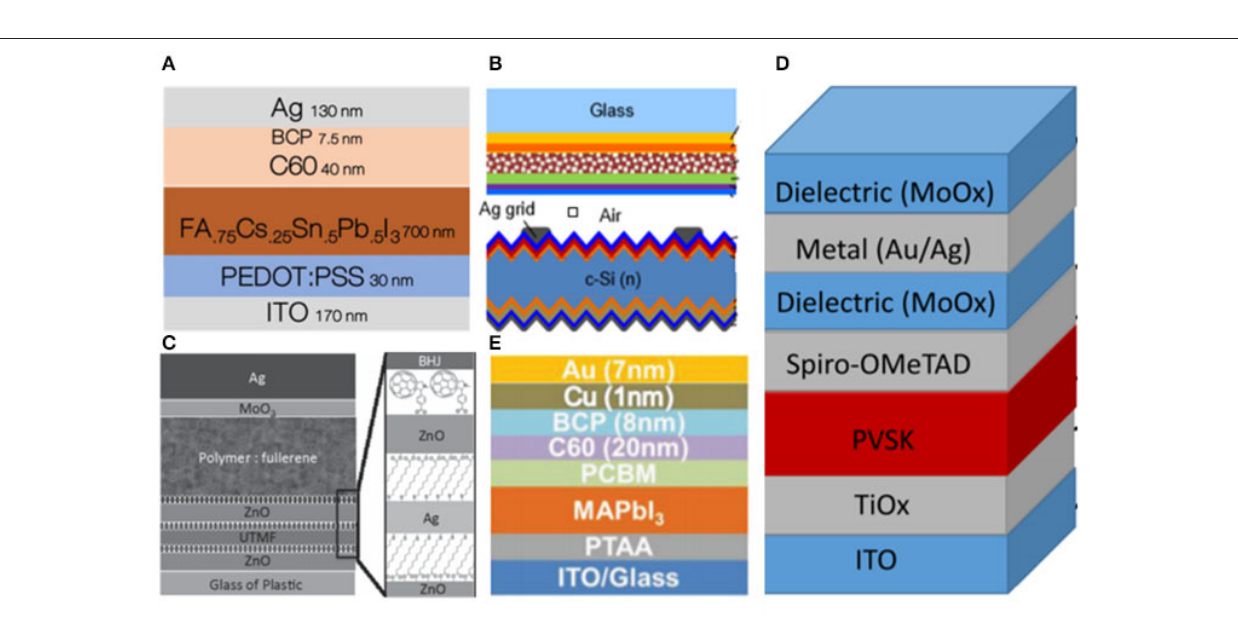
FIGURE 5 | (A) Device schematic of the single junction solar cell (reproduced from ref. 33, copyright 2018, Royal Society of Chemistry). (B) Schematic of the mechanically stacked 4T tandem (reproduced from ref. 34, copyright 2014, Royal Society of Chemistry). (C) Schematic drawing of the PSC devices and the molecular structure of MUA and C 60 -SAM employed for interfacial modifications (reproduced from ref. 35, copyright 2014, Wiley VCH). (D) Device structure and performance of top illuminated PVSK solar cell (reproduced from ref. 36, copyright 2015, ACS). (E) Schematic drawing of tandem cells (reproduced from ref. 37, copyright 2016, Wiley